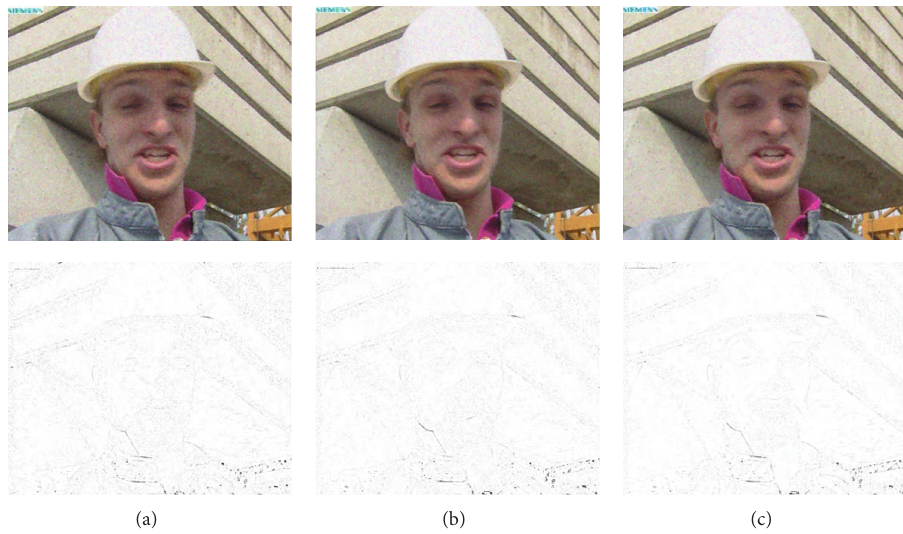
Figure 8: Filtered 80th frame of Foreman video (first row) and respective error images (second row) in case of 𝜎 2 = 0.010 noise intensity of additive noise: NLM [52] (a), VBM3D [50] (b), and FMANS 3D (c) filters. The value of each error pixel is amplified 3 times in order to distinguish the details.